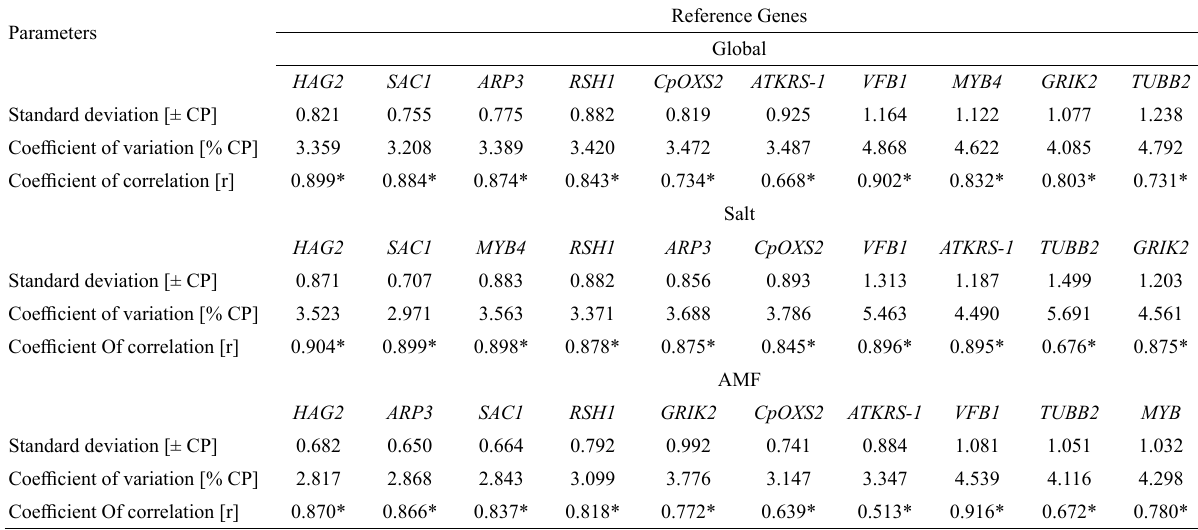
Table 3 – Ranking of 10 reference genes according BestKeeper software in global time combination of roots of C. pyramidale under salt stress and associated with arbuscular mycorrhizal fungi (AMF).